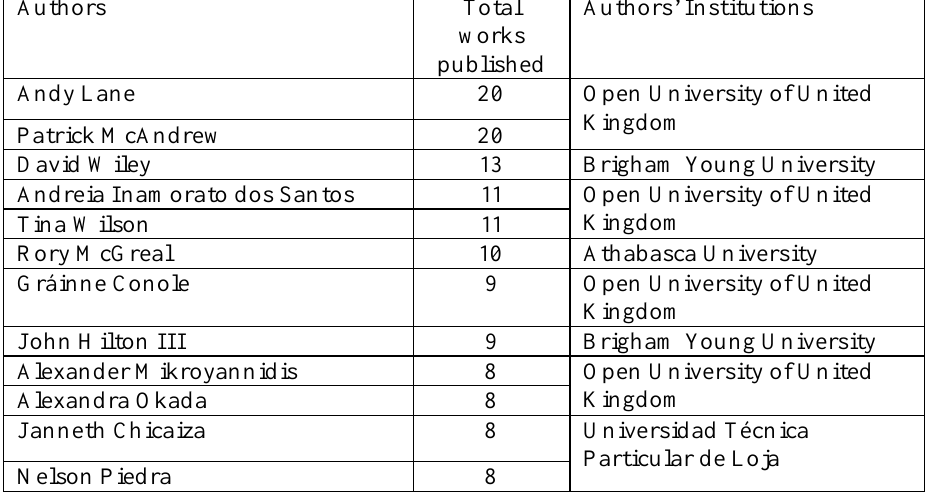
Authors with the Highest Number of Publications and their Institutions Authors Total